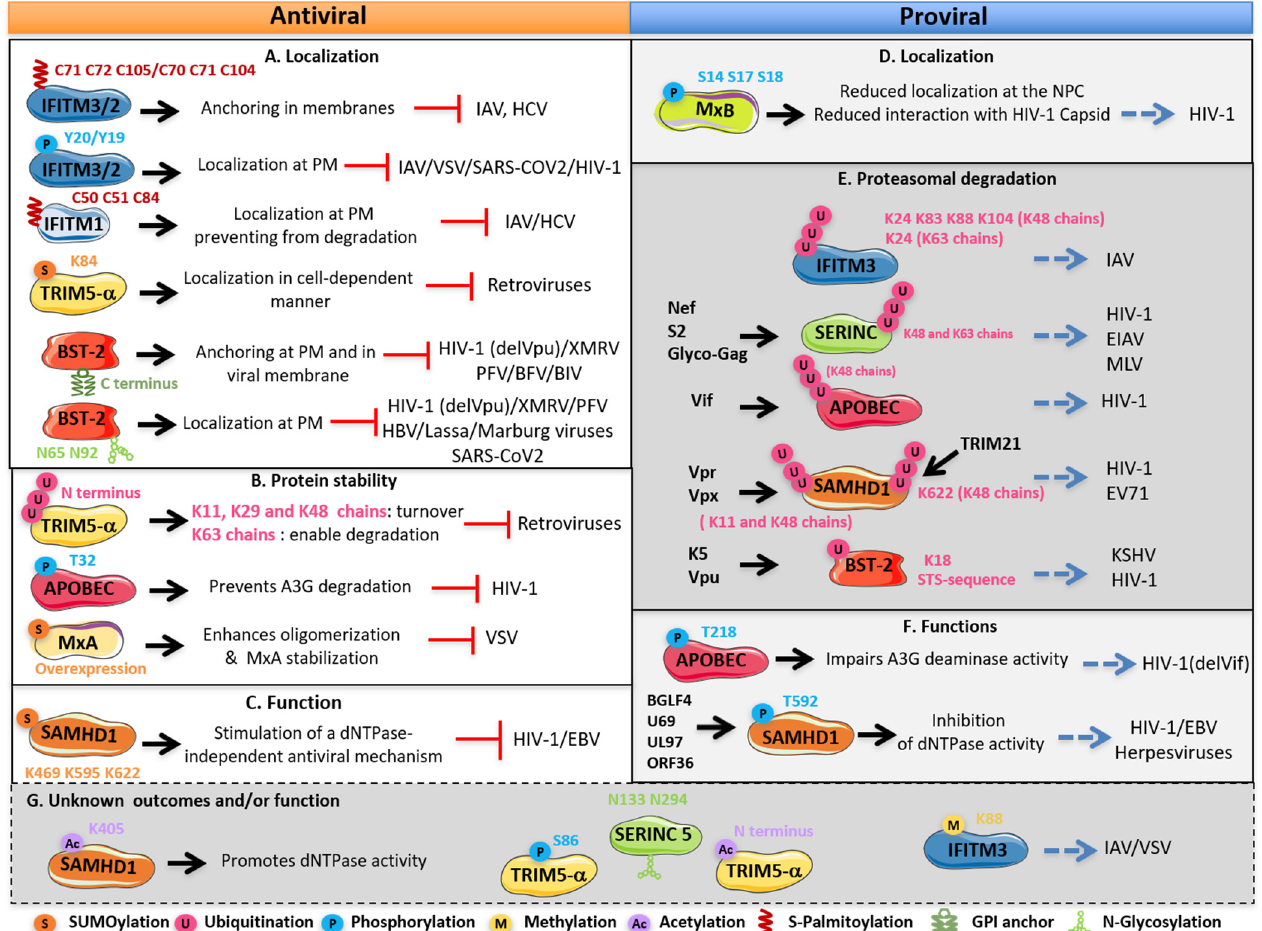
Figure 3. Regulation of human restriction factor activities and outcomes by PTMs. ( A , B , C ) Antiviral effects of the PTMs, ( D , E , F ) proviral effects of the PTMs on the restriction factors and ( G ) unknown outcomes and/or function of the PTMs on the restriction factors. Restriction factors with the modified residues are illustrated. For each factor, the mechanism involved, the outcome of modified factors, the effect on viruses and the viral proteins antagonizing these factors are indicated. PM: plasma membrane; NPC: nuclear pore complex.